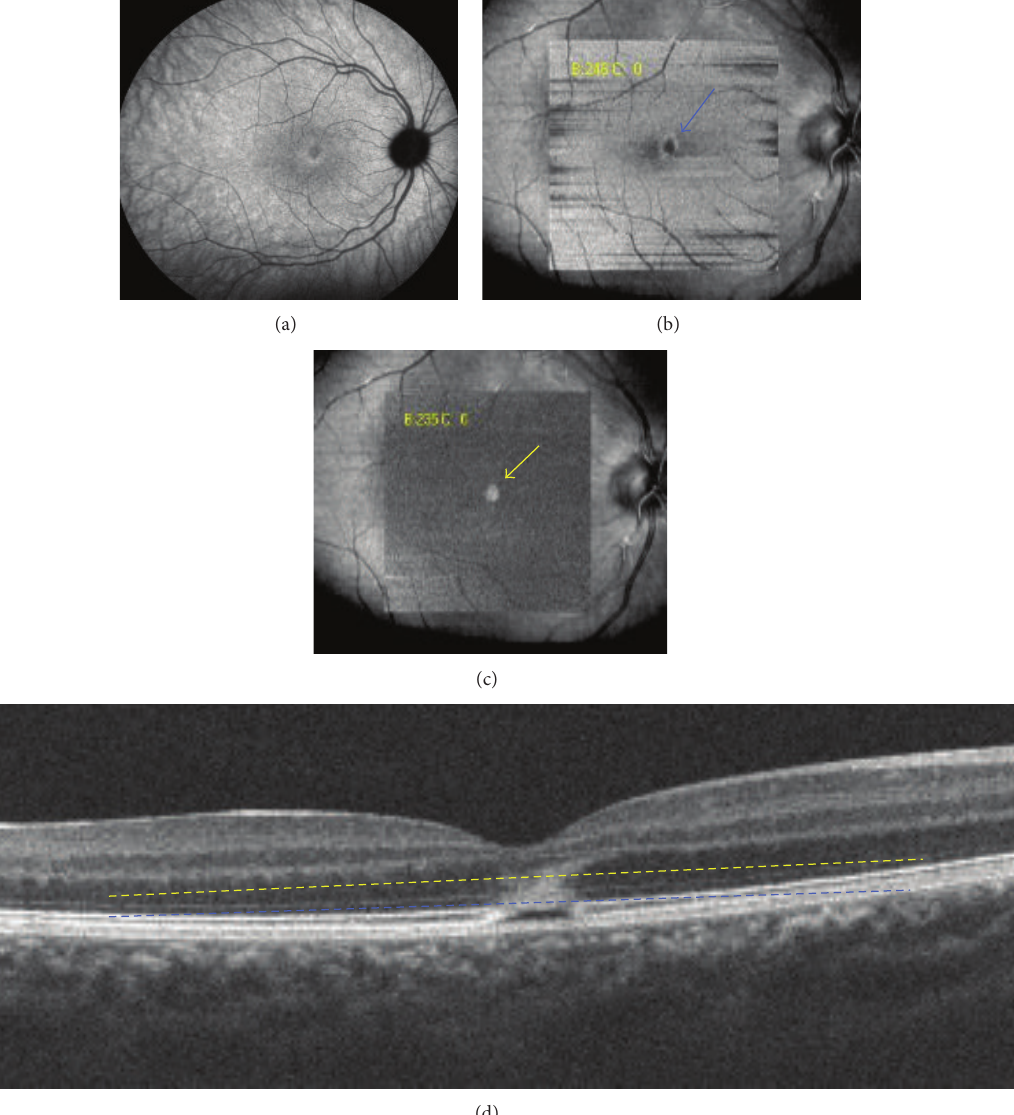
Figure 3: Patient 1, right eye. (a) Indocyanine green angiography (18 minutes), at the initial visit, showing a cockade-like lesion in the macular area at the level of the IS-OS junction. (b) “En-face” spectral-domain optical coherence tomography showing a central cockade-like lesion with a hyporeflective center and a hyperreflective border (blue arrow). (c) “En-face” OCT showing a hyperreflective punctuate lesion located in the outer nuclear layer (yellow arrow). (d) B-scan spectral-domain optical coherence tomography showing hyperreflective edges of the disrupted lesion corresponding with the cockade-like lesion and a hyperreflective lesion in the outer nuclear layer corresponding with the central hyperreflective point on “en-face” OCT (yellow and blue